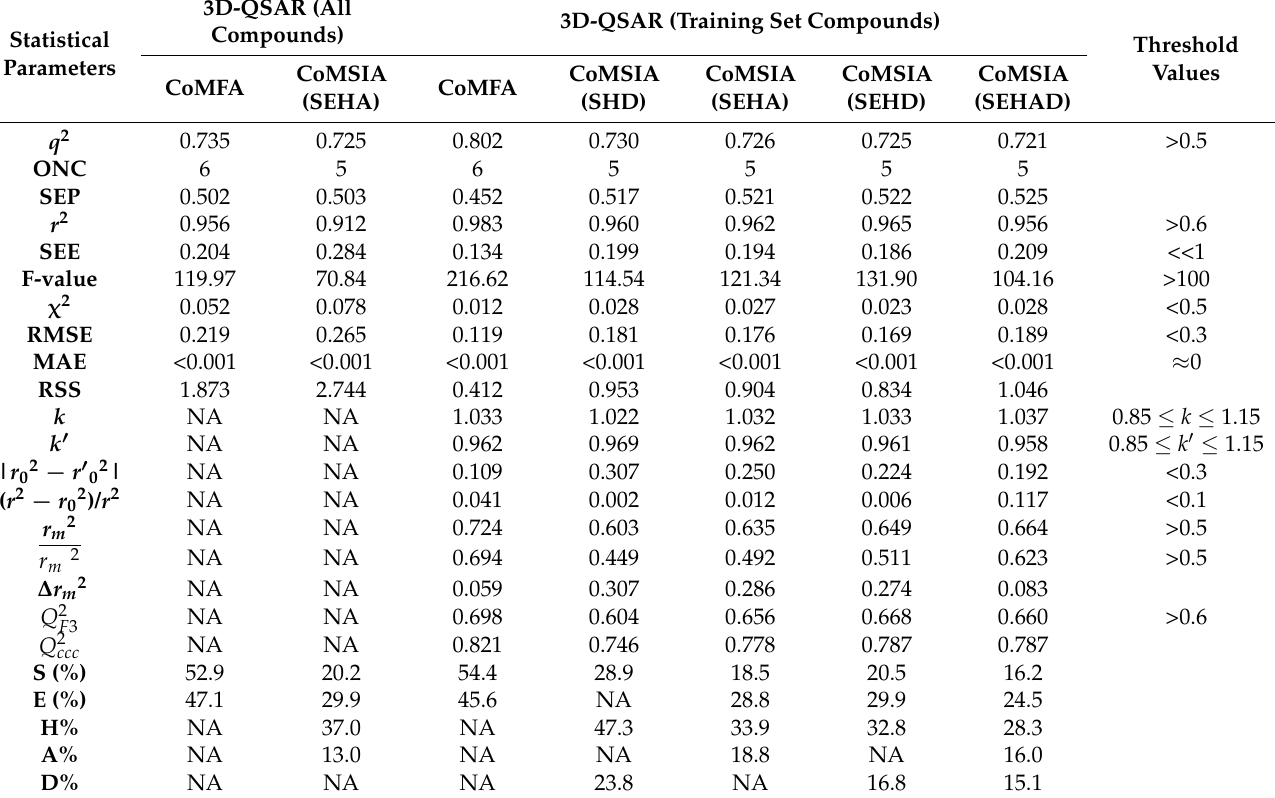
Table 3. Statistics of the CoMFA and CoMSIA